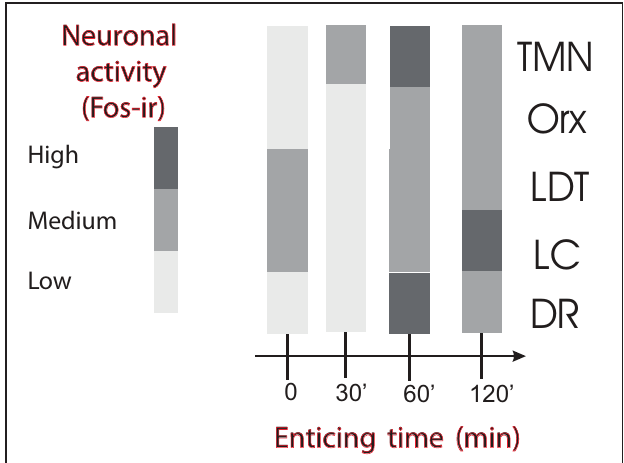
FIGURE 5 | Temporal course of ascending arousal system nuclei activation during appetitive behavior induced by enticing hungry rats with unreachable food. The level of neuronal activity, evaluated by Fos expression, is indicated by the grayscale. The four bar graphs correspond to rats that have fasted for 24h and were sacrificed immediately before the beginning of the enticing procedure (time 0) or killed after the indicated times (30–120min). Note that the first nucleus to increase Fos-ir 30min after the beginning of enticing was the TMN. The other arousal nuclei increased Fos-ir after 60min and continued with medium to high Fos-ir at 120min. DR, dorsal raphe; LC, locus coeruleus; LDT, laterodorsal